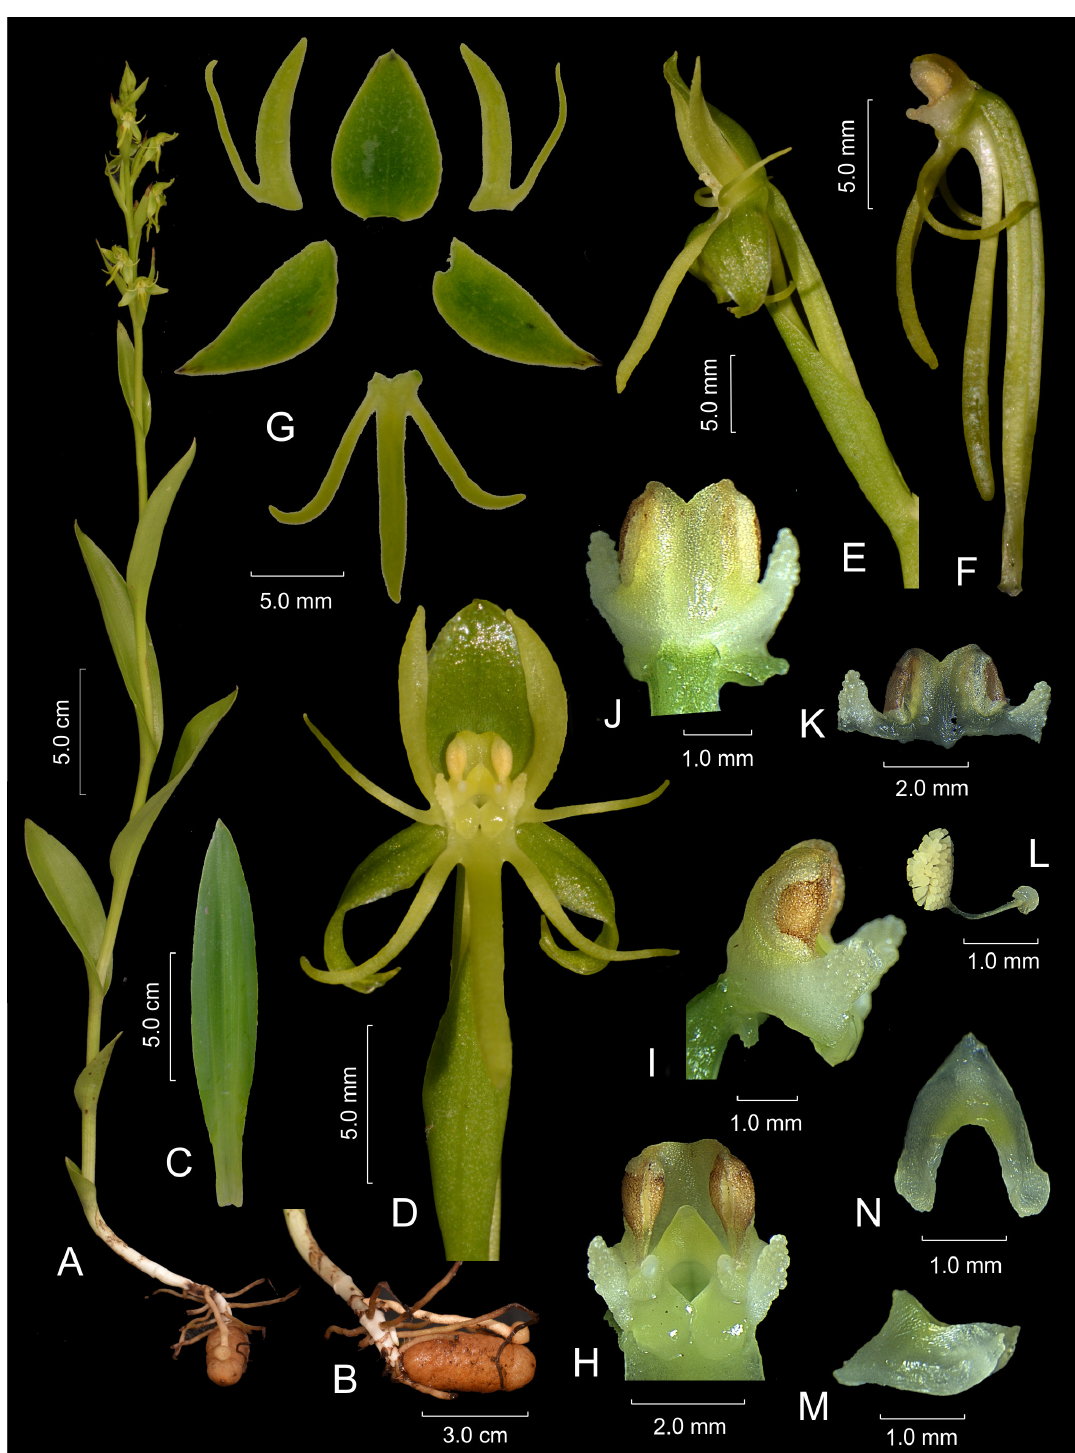
Fig. 4. Habenaria karstica J.A.N.Bat. sp. nov. A . Habit. B . Stem base, roots and tuberoid. C . Leaf. D . Flower, front view. E . Flower, side view. F . Pedicellate ovary, gynostemium, lip and spur, side view. G . Dissected perianth. H . Gynostemium, front view. I . Gynostemium, lateral view. J . Gynostemium, dorsal view. K . Dissected connective, anthers and auricles. L . Pollinaria. M . Rostellum, side view. N . Rostellum, upper view. All images from the type material, J.A.N. Batista et al. 3649